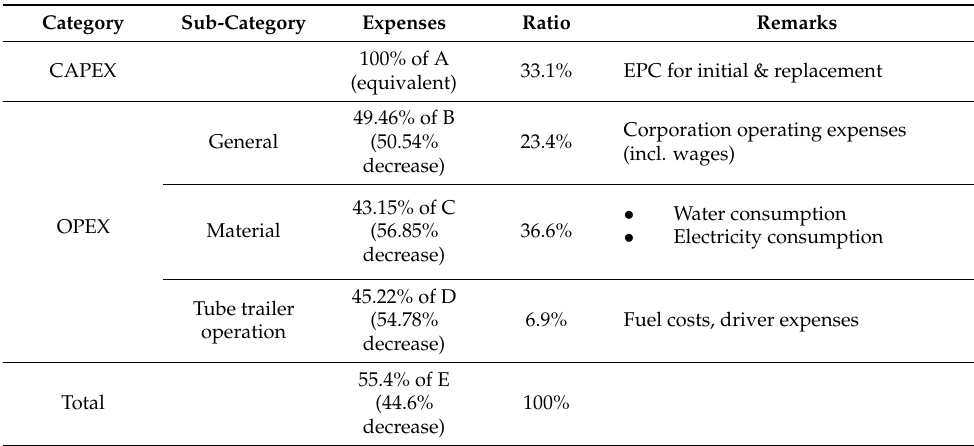
Table 22. Estimation of whole expenses and breakdown (Scenario